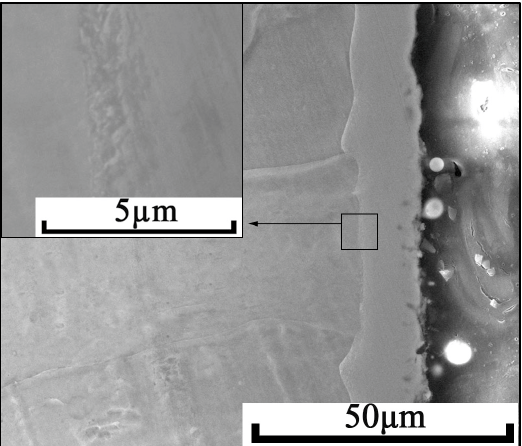
Figure 2. Cross-section morphology of the alloyed